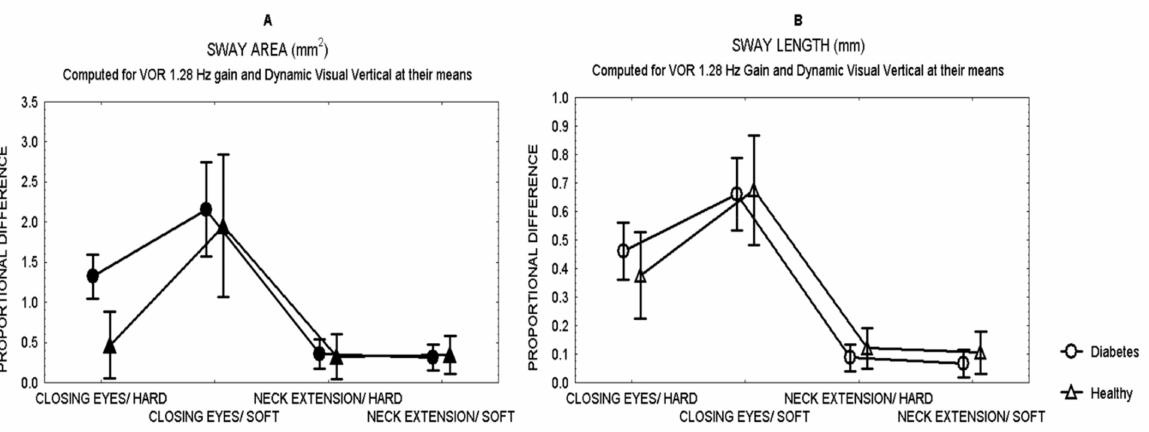
Figure 1. Mean and standard error of the mean of the proportional difference in the area of sway ( A ) and the length of sway ( B ) of patients with type 2 diabetes and healthy subjects, after closing the eyes or 30 ◦ neck extension, while standing either on hard or soft